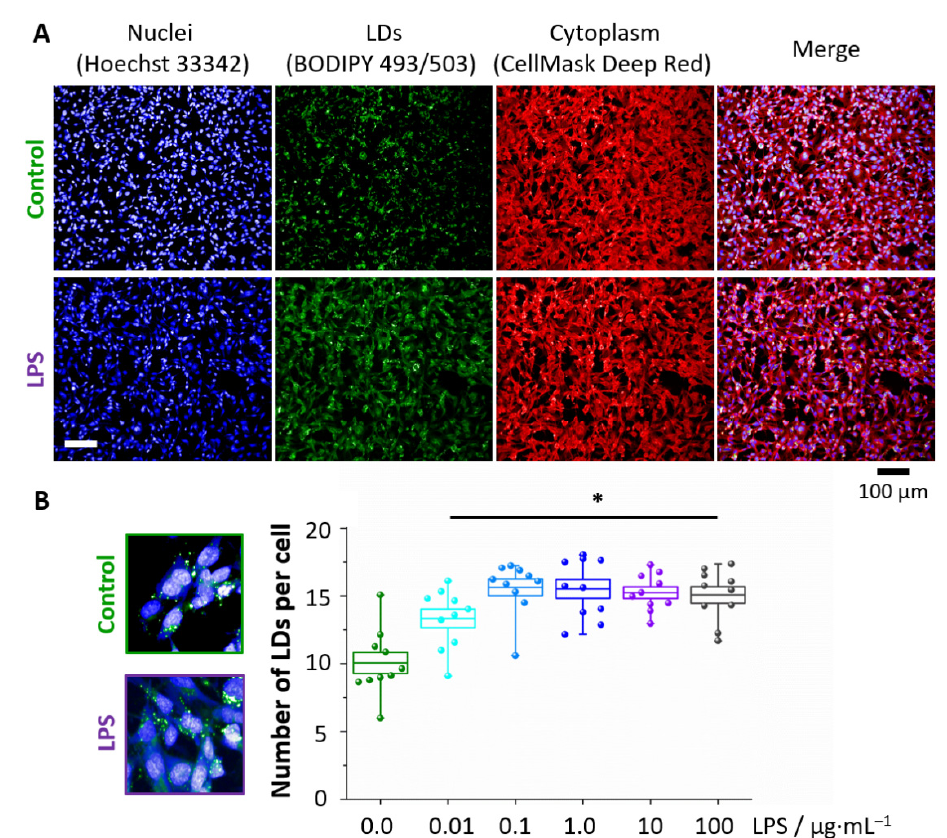
Figure 2. Formation of LDs in LPS-stimulated endothelial cells. Representative fluorescence images ( A ) of control and LPS-treated HMEC-1 (10 μ g·mL − 1 , 24 h) showing the distribution of nuclei (blue, Hoechst 33342), lipid droplets (green, BODIPY 493/503) and cytoplasm (red, Cell Mask Deep Red) that enabled for calculations of the number of LDs per cell ( B ). Values given as mean ± SEM are shown in box plots: mean (horizontal line), SEM (box), minimal and maximal values (whiskers). * p < 0.05.